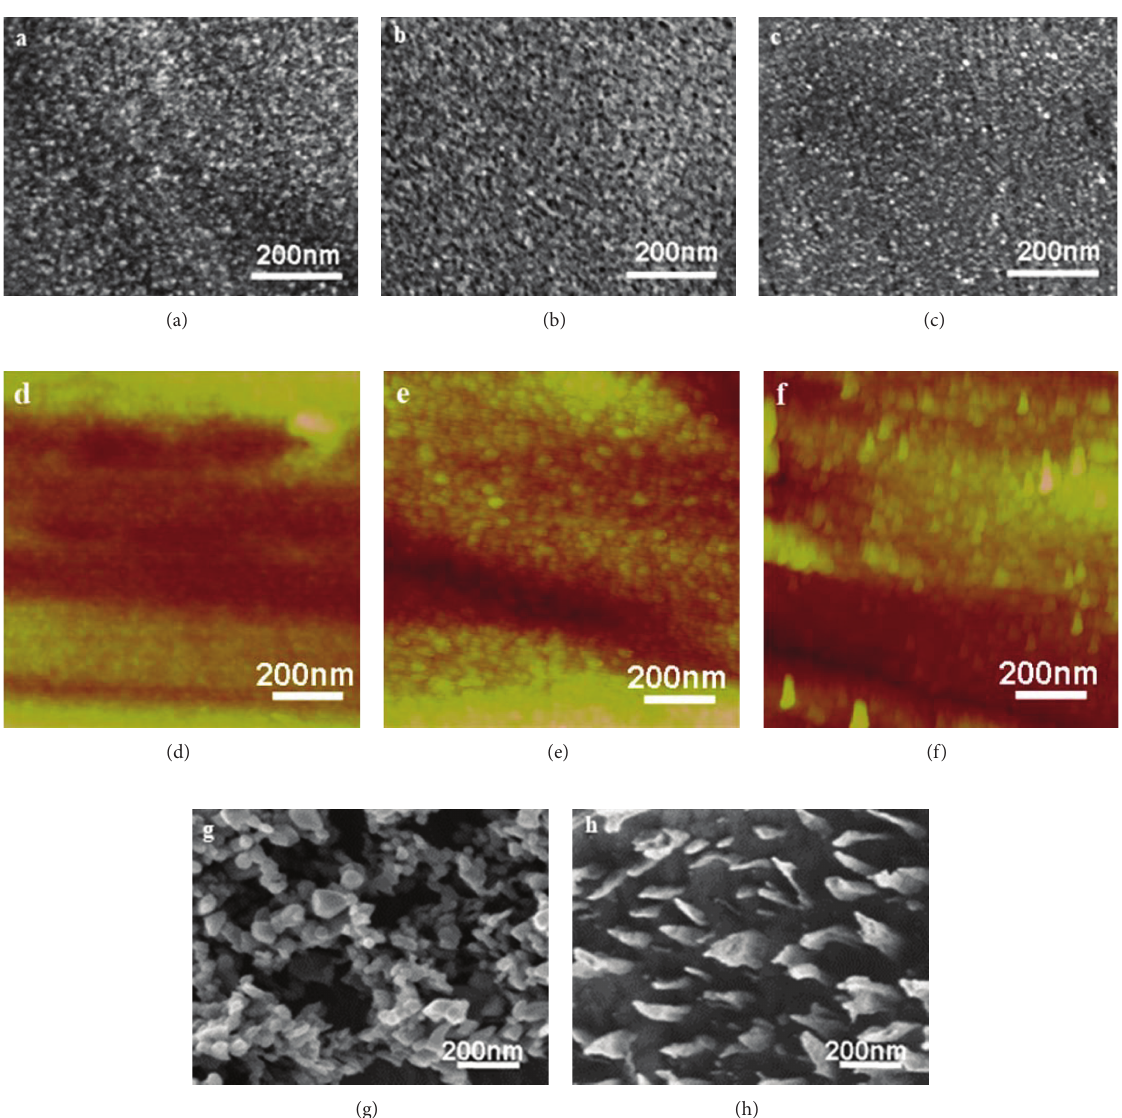
Figure 2: SEM images for the (a) TS + 8nm, (b) TS + 22nm, (c) Au + 22 nm, (g) TS + P25, and (h) TS + AT-I surfaces. AFM images for the (d) TS + 8nm, (e) TS + 22 nm, and (f) Au + 22 nm